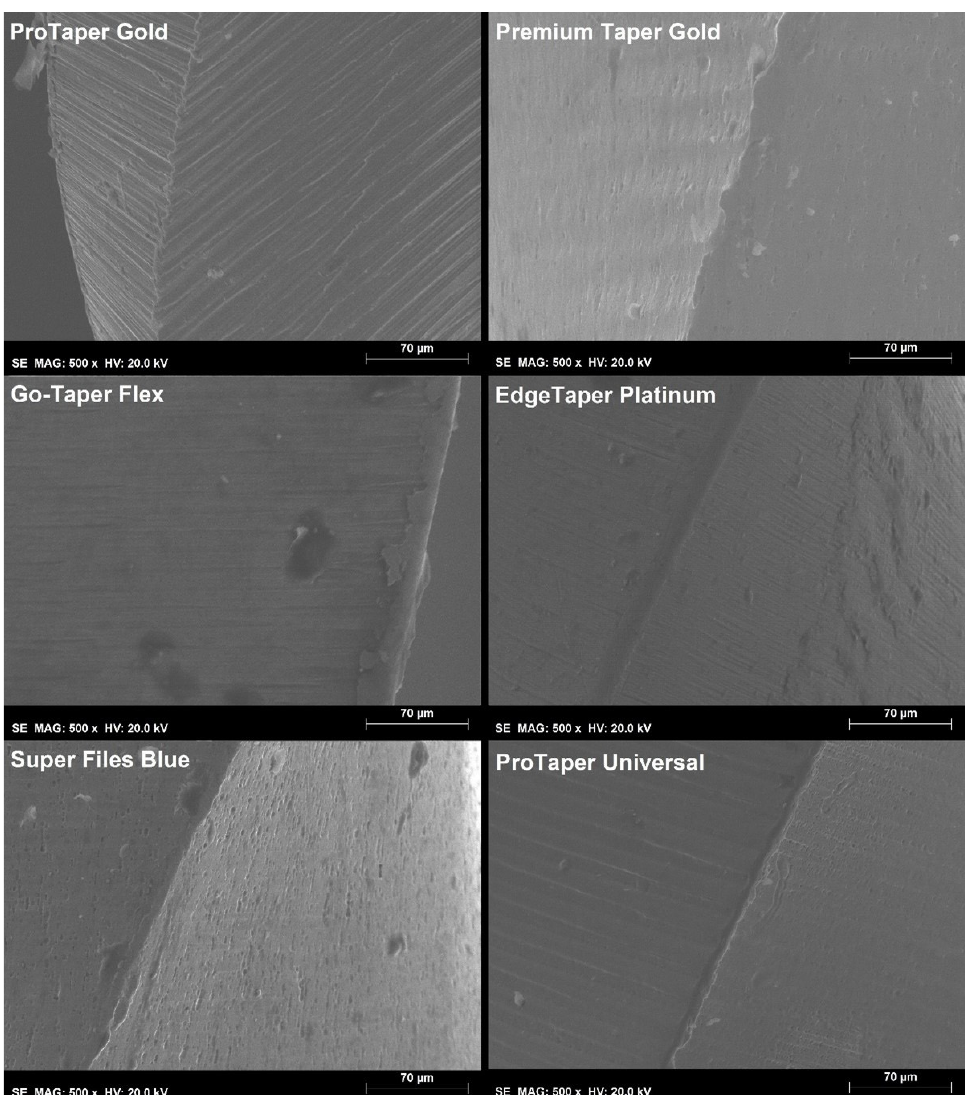
Figure 3. SEM images of the instruments’ surfaces showing distinct marks from the manufacturing process in both ProTaper Gold and ProTaper Universal, porosities of different sizes on the Super Files Blue surface, and less irregularities in the Premium Taper Gold instrument.